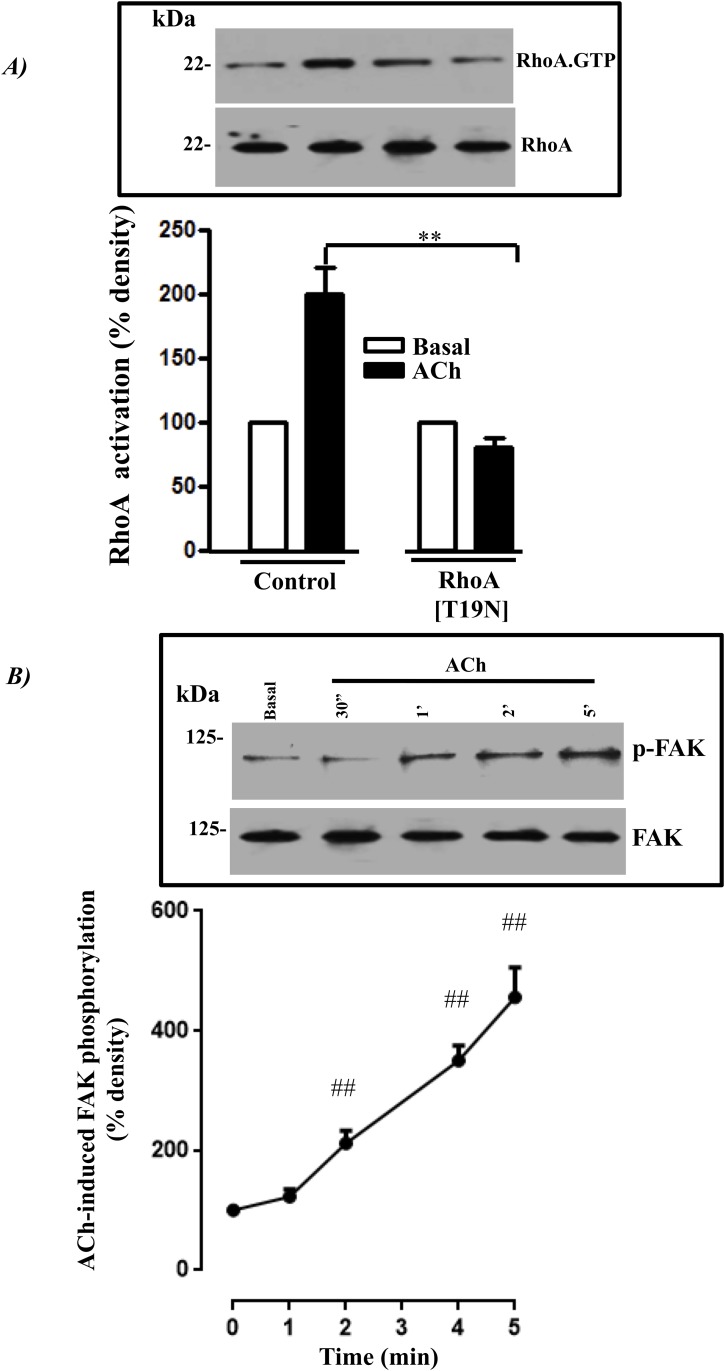
Stimulation of RhoA activity and phosphorylation of FAK by acetylcholine (ACh).A: Cultured smooth muscle cells expressing either control vector or RhoA dominant negative (RhoA [T19N]) were treated for 10 min with 1 μM ACh. Immunoprecipitates derived from 500 μg of protein using the glutathione S-transferase-tagged Rho-binding domain region of Rhotekin beads were separated using SDS-PAGE and immunoblotted using RhoA antibody; the results are expressed as densitometric values. Values are means ± SE of four experiments. B: Immunoblots of FAK and phospho-FAK (Y397) from extracts of smooth muscle cells either unstimulated or stimulated with 1 μM ACh for different time periods ≤ 5 min. Phosphorylation of FAK was measured using phospho-specific Tyr FAK (Y397) antibody. The results are expressed as densitometric values. Values are means ± SE of five experiments. **P<0.001, ## P<0.01.